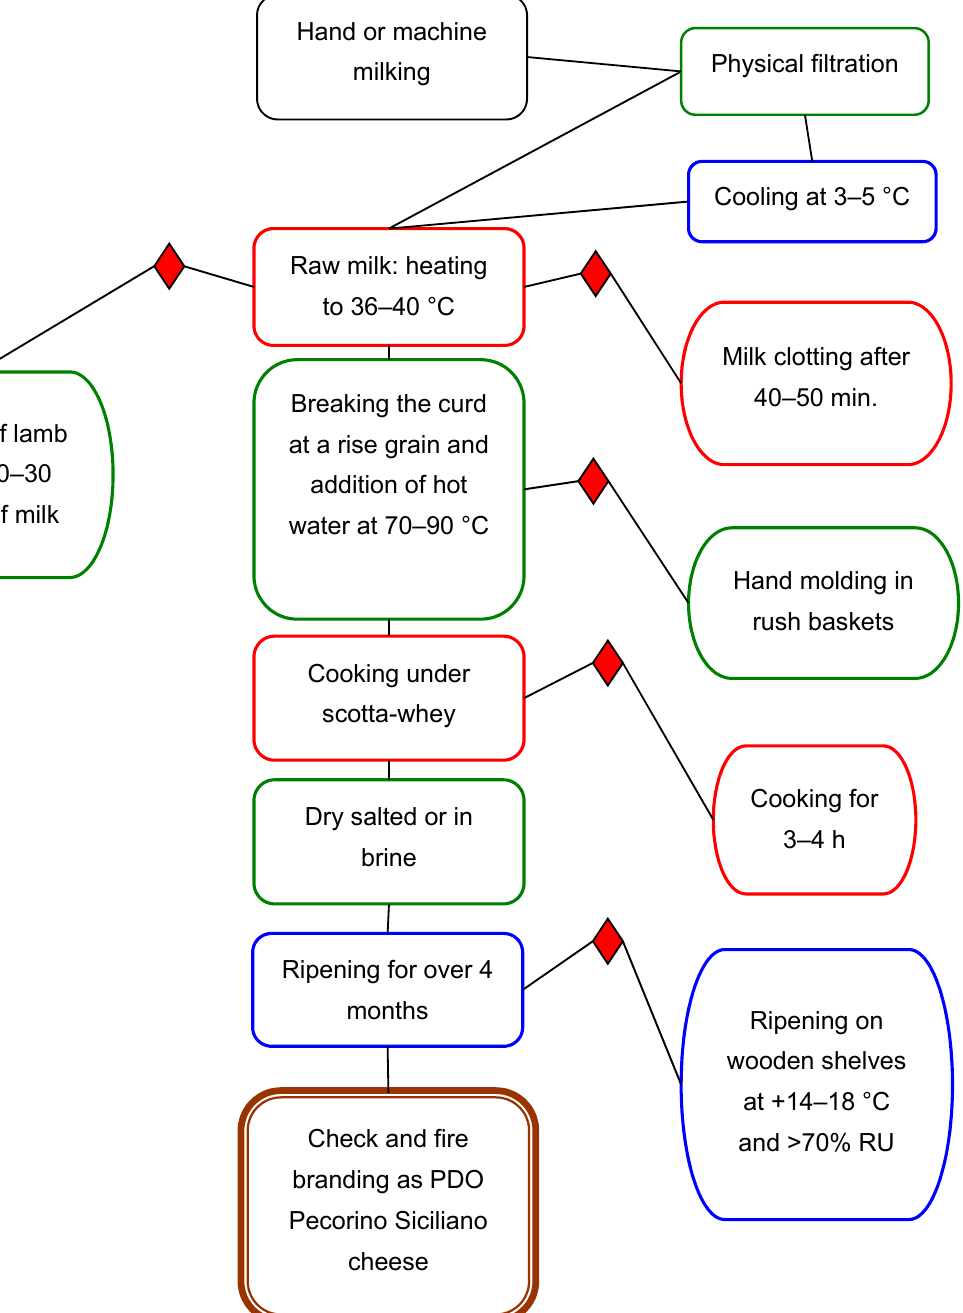
Figure 1. Flow chart of PDO Pecorino Siciliano cheese.